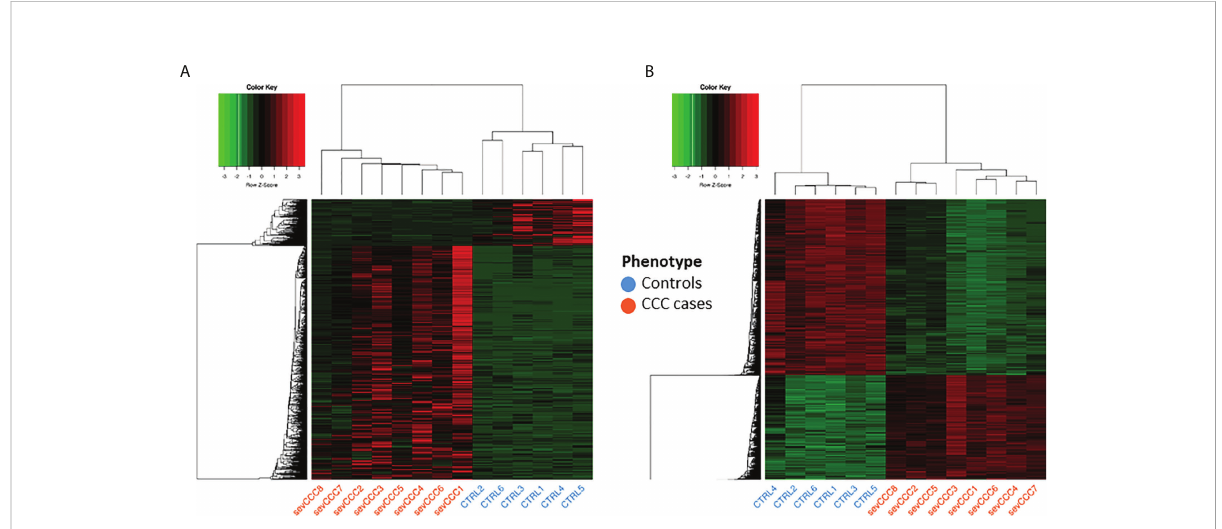
FIGURE 2 Analysis of samples clustering based on differentially expressed genes or differentially methylated CpG sites. Control samples identi fi ers are written in blue whereas case samples identi fi ers are written in red. (A) Hierarchical Clustering Analysis (HCA) performed on 6 control and 8 case samples, based on expression of 1409 differentially expressed genes. (B) Hierarchical Clustering Analysis (HCA) performed on the same samples as in A), based on methylation level of 16883 differentially methylated